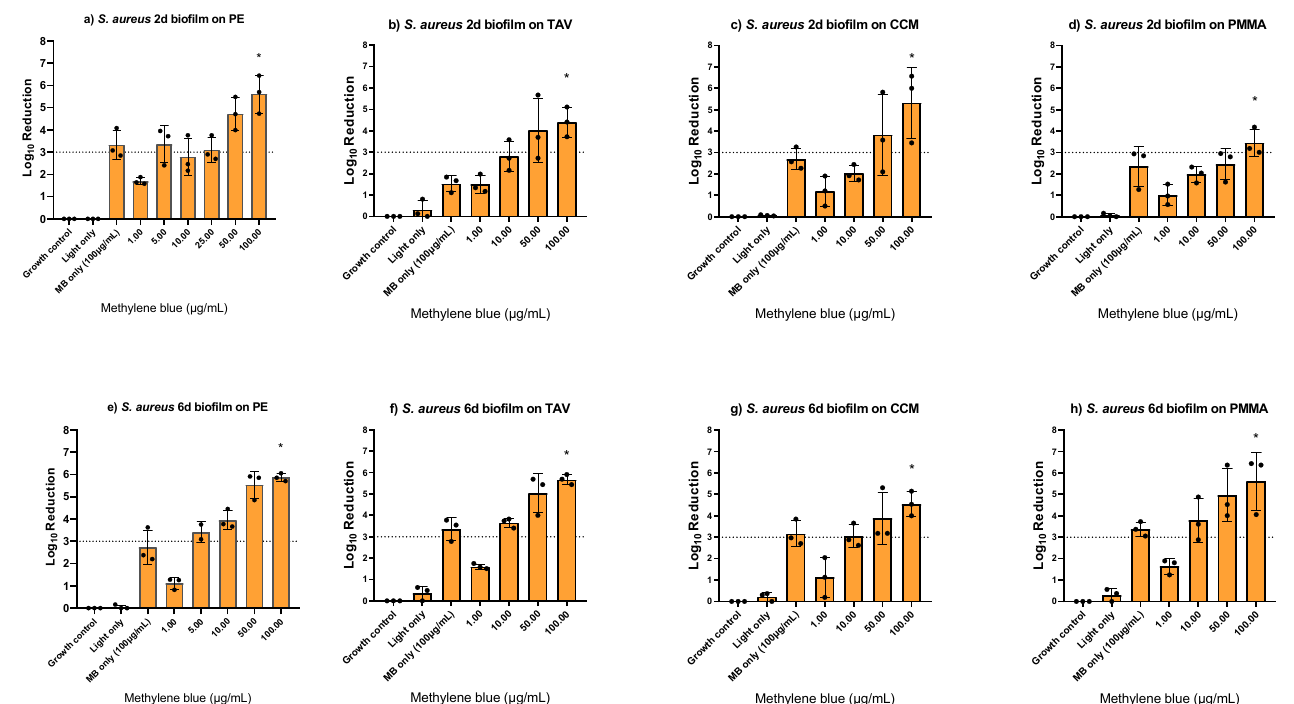
Figure 2. Photodynamic inactivation of Staphylococcus aureus biofilms formed on polyethylene (PE), titanium alloy (TAV), cobalt-chromium-molybdenum (CCM), and polymethyl methacrylate (PMMA) based bone cement discs using different concentrations of methylene blue (MB). Panels ( a – d ) show two-day-old biofilms, panels ( e – h ) show six-day-old biofilms. The bars show the average log 10 reduction with the standard deviation from two or three independent biological replicates. The dotted line signals a bactericidal effect (3 log 10 reductions). The stars (*) above the bars indicate 100% killing, i.e., no regrowth. MB only controls were performed with the determined minimum bactericidal concentration without regrowth (MBC 100% ).